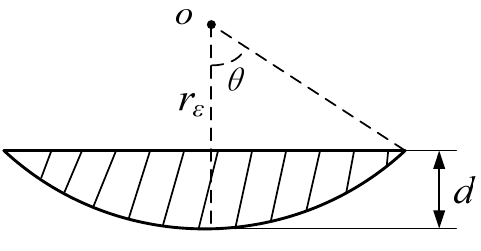
Figure 5. Cross section of the plunge-cut